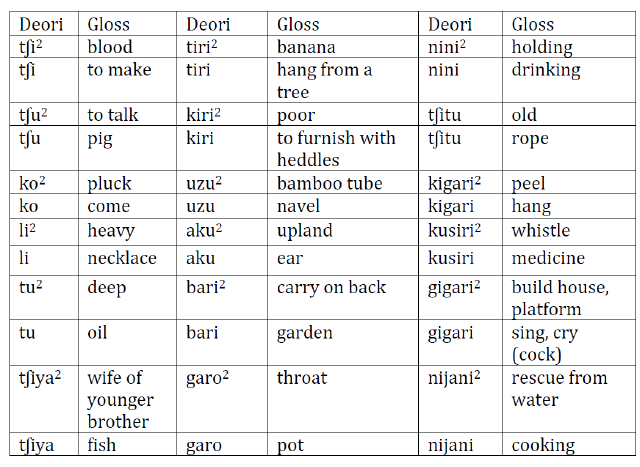
Table 7: Tone list used for the production